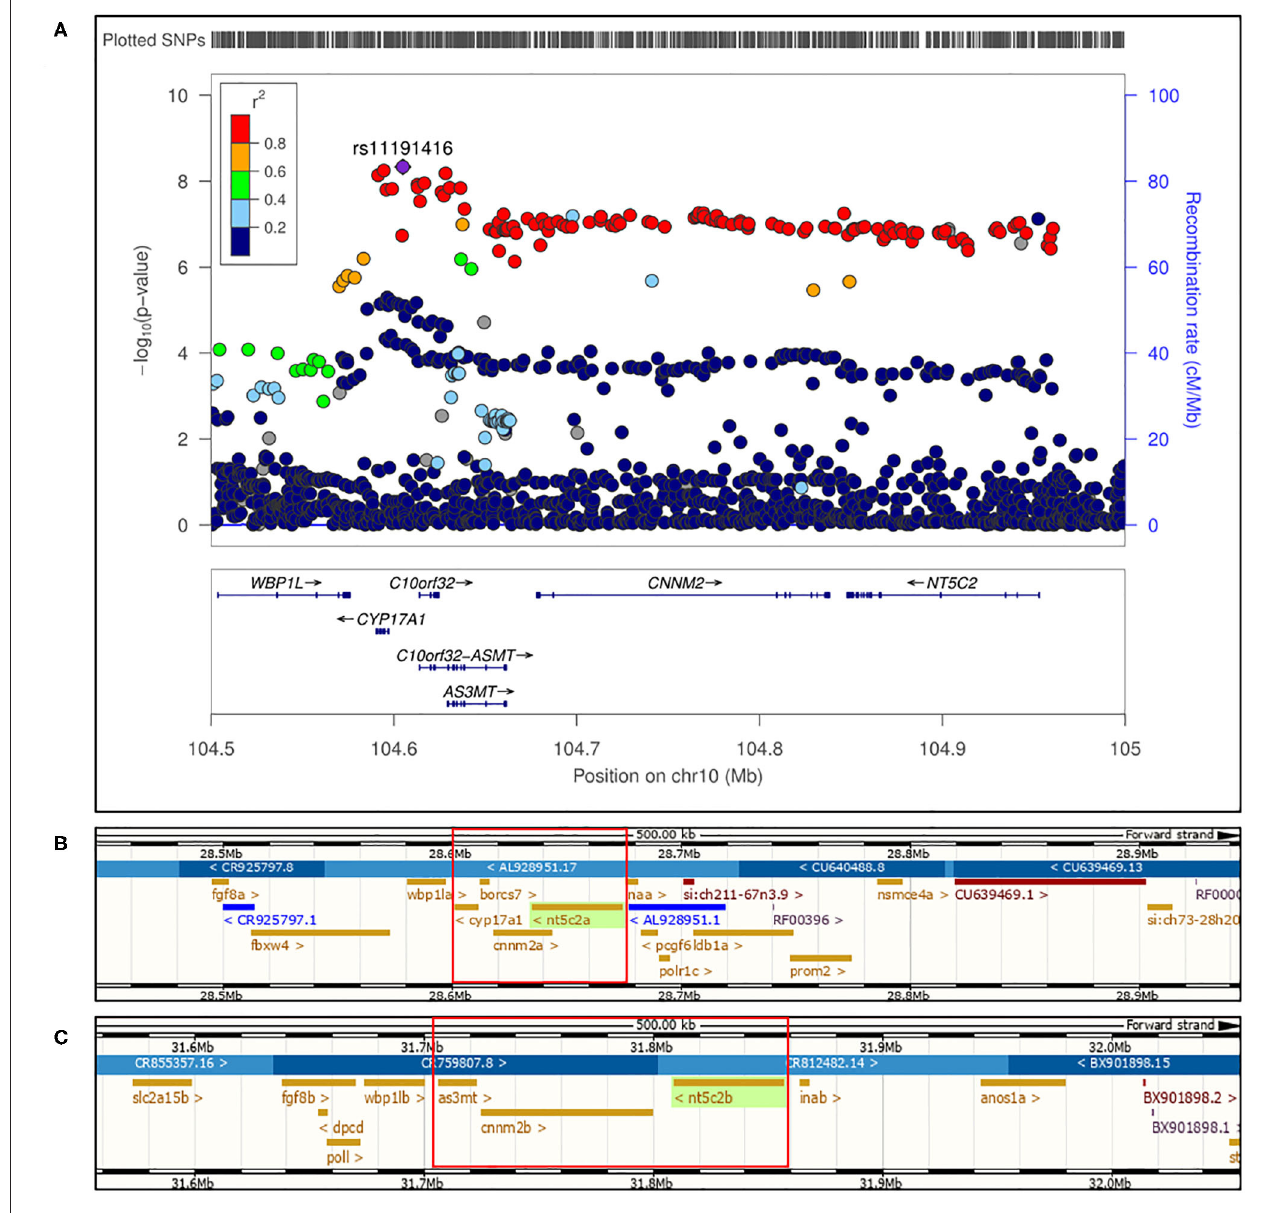
FIGURE 1 | (A) Regional association plot for human locus 10q24.32 on chromosome 10 showing genome wide significant single nucleotide polymorphisms for blood pressure phenotype. Figure adapted from (17). (B) First part of 10q24.32 locus conserved in zebrafish genome at chromosome 13 encompassing “a” paralogs of cnnm2, nt5c2, and cyp17a1 with borcs7 . (C) Second part of 10q24.32 locus region conserved in zebrafish genome at chromosome 1 encompassing “b” paralogs of cnnm2 and nt5c2 , along with as3mt genes.